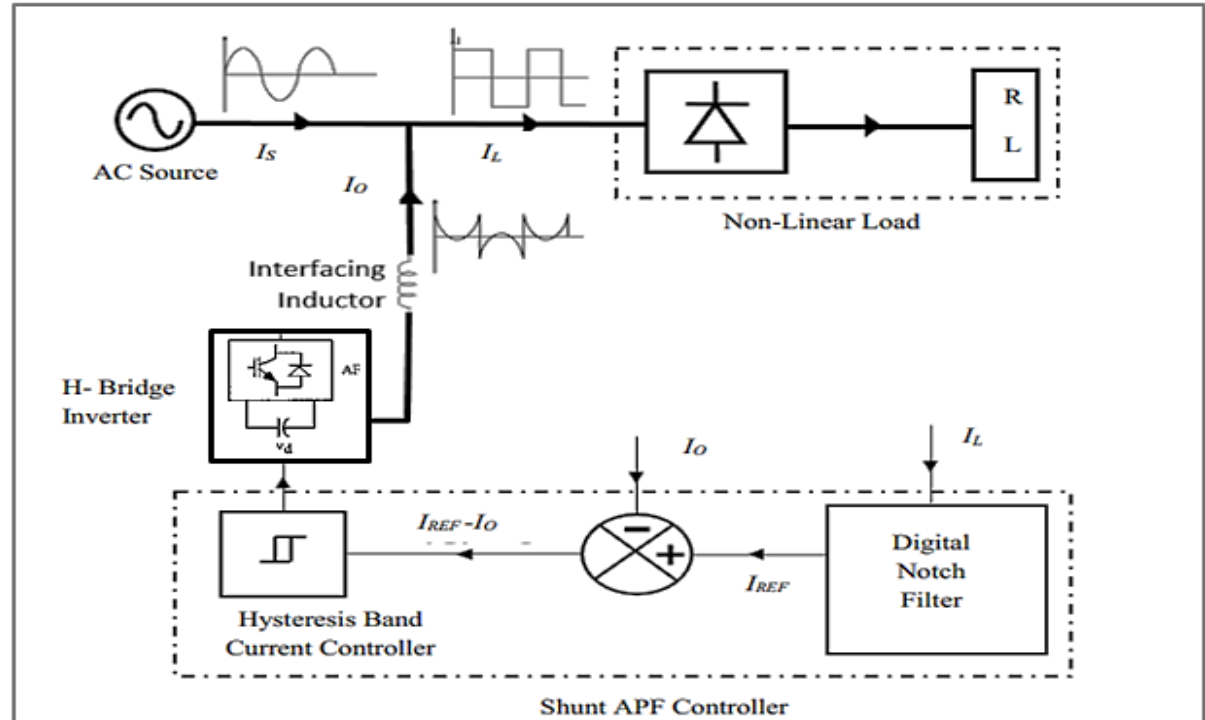
Figure 1. Shunt active power filter structure .